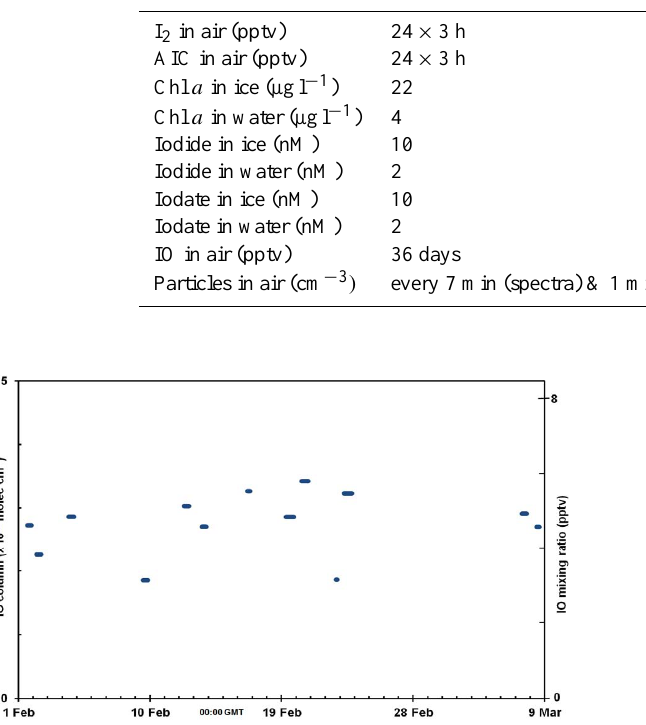
Table 3. Measurements other than halocarbons during the Weddell Sea cruise. Measurement